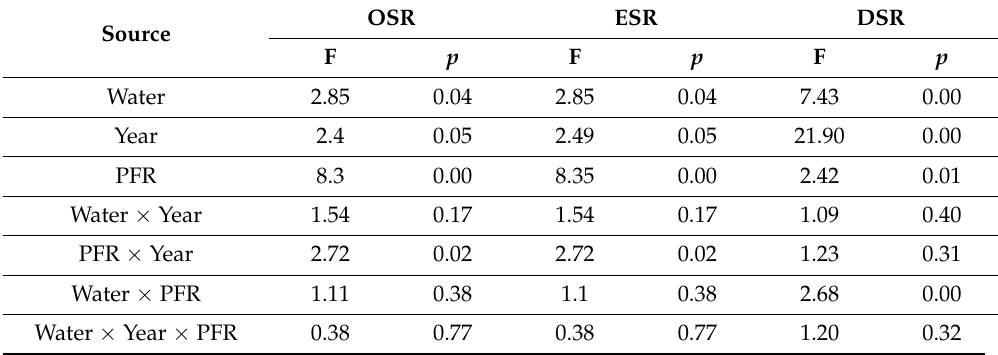
Table 1. F- and p -values of linear mixed model (MIXMOD) analysis of the fixed effects of water addition treatments (water), year, the preceding phenological event (peak of the fruit ripening, PFR), and their interactions with the onset (OSR), end (ESR) and duration of (DSF) seed release from 2012–2018.